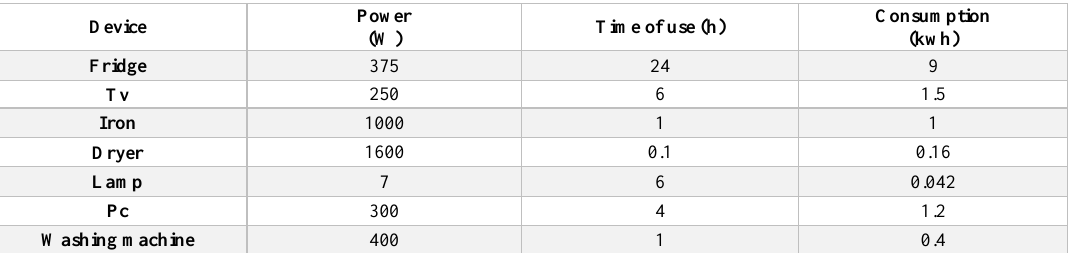
Table 1. Electronic devices and their